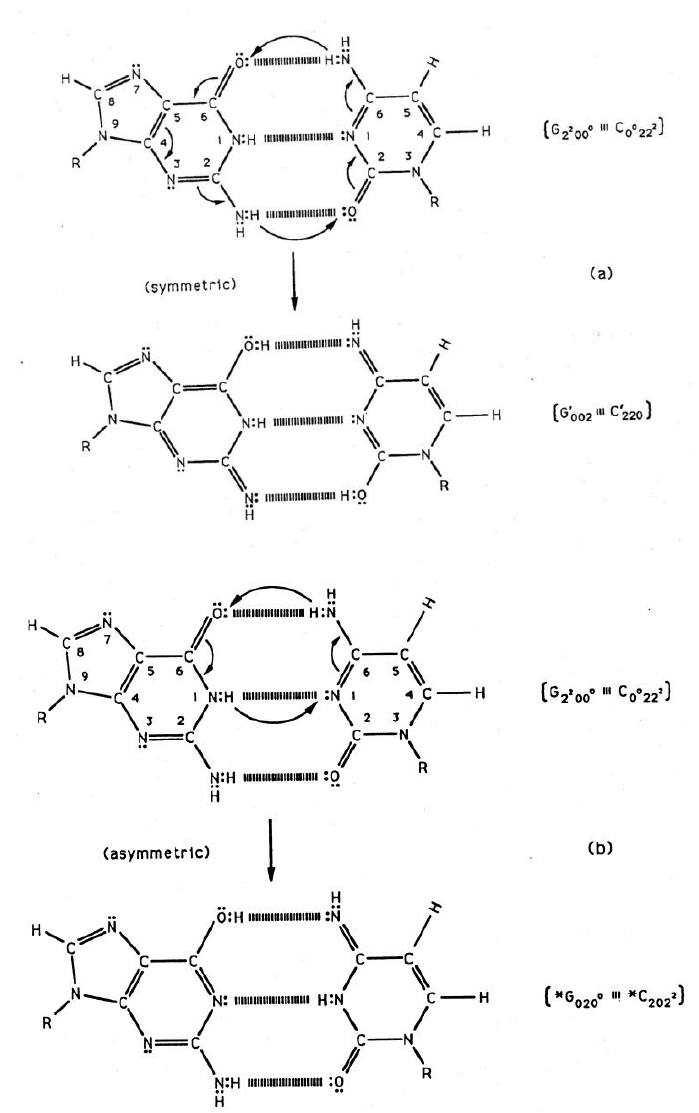
Figure 1. (a) Symmetric proton exchange and electron rearrangement at a G-C site. (b) Asymmetric proton exchange and electron rearrangement at a G-C